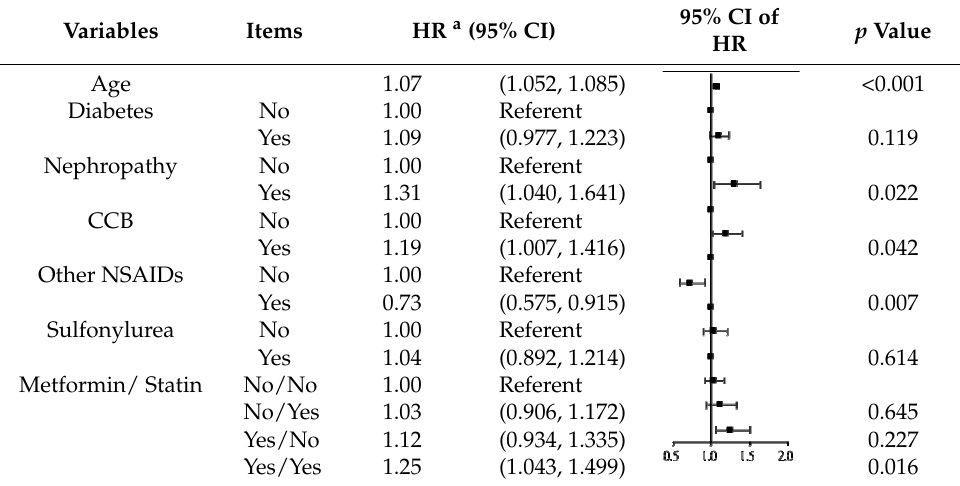
Table 3. Multivariate analysis of the incidence of colon cancer in women aged 40–64 years with the combination of statins and metformin.